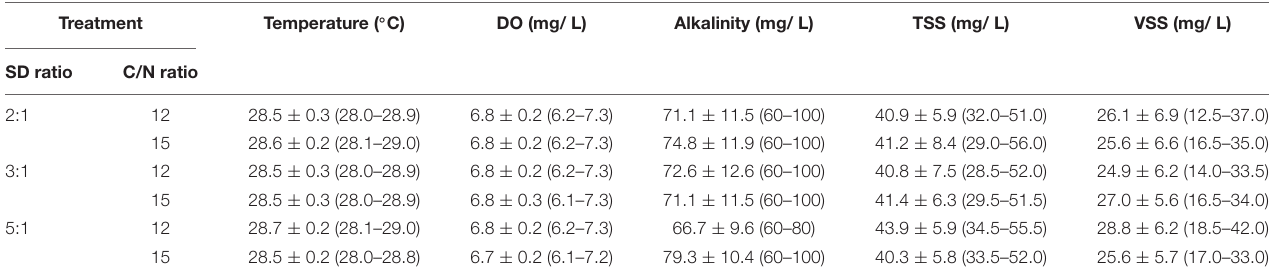
TABLE 5 | Average yield and mineral nutrient concentrations of the three halophytic plants cultivated in marine aquaponics at three stocking density ratios (SD ratio) of shrimp to plant and two C/N ratios for 4 weeks. Plant species Treatment Yield (kg/m 2 )